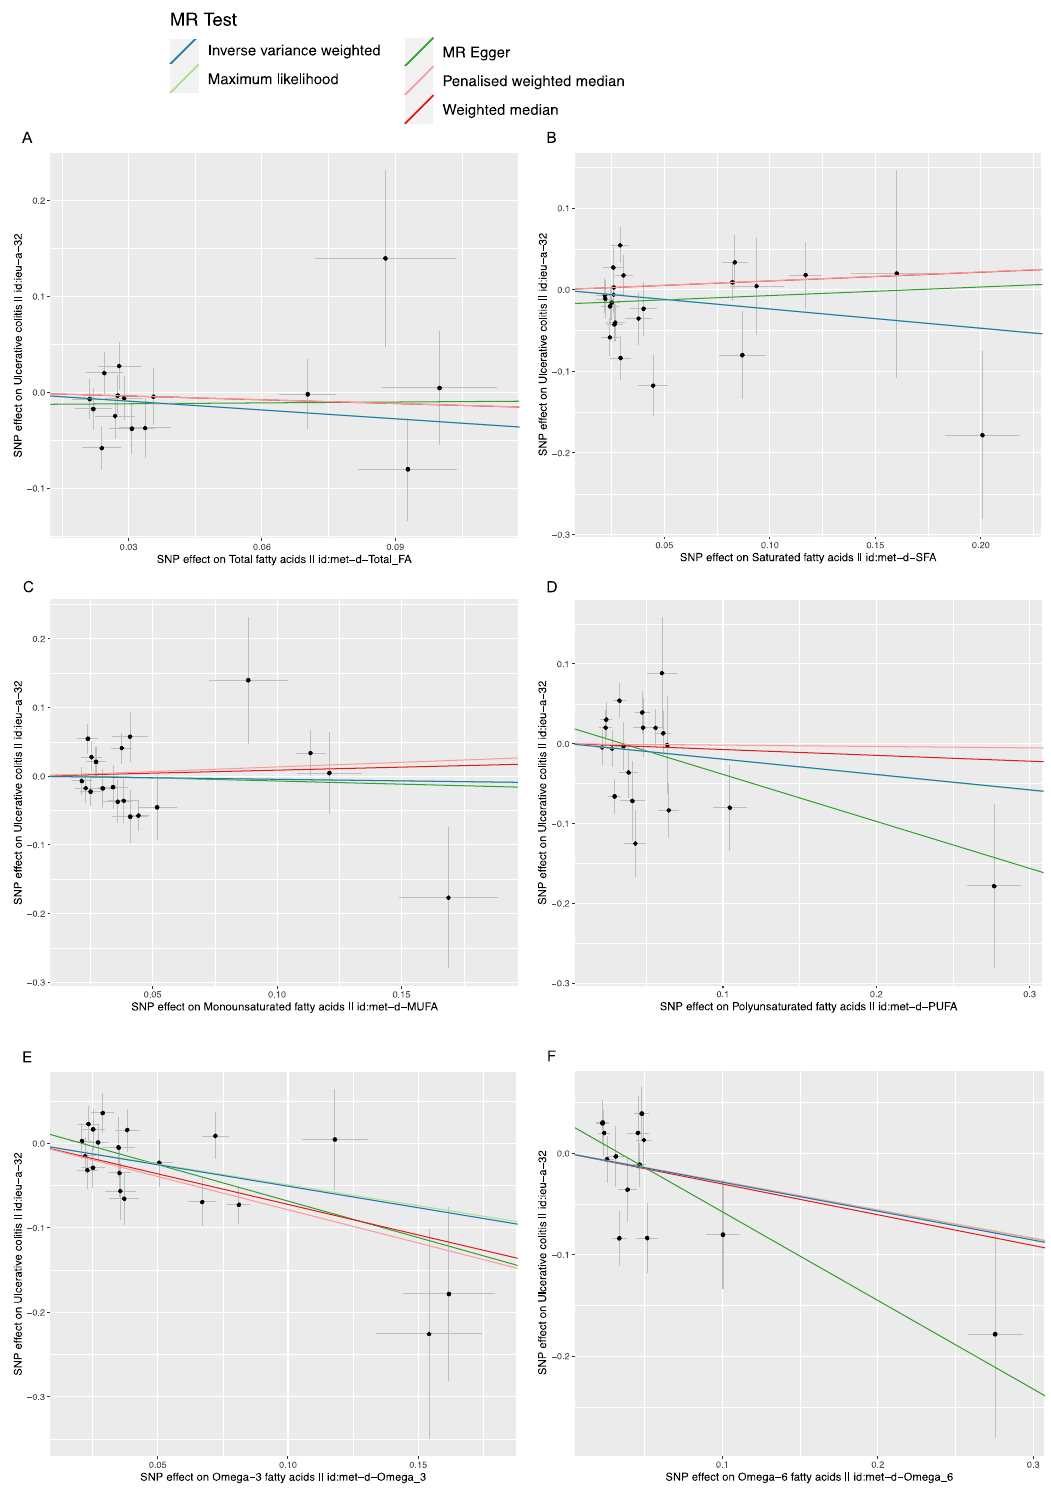
Figure 2. The scatter plot of fatty acids (FAs) and Ulcerative colitis (UC), X -axis, the single nucleotide polymorphism (SNP) effect and standard errors (SEs) on each of the selected SNPs from FA genome-wide summary association study (GWA) dataset Y -axis, the SNP effect and SEs on UC from Crohn’s disease (CD) Genome-wide summary association study (GWA) datasets. ( A ) Analysis of Total FA and UC; ( B ) Analysis of saturated FA and UC; ( C ) Analysis of monounsaturated FA and UC; ( D ) Analysis of polyunsaturated FA and UC; ( E ) Analysis of Omega-3 FA and UC; ( F ) Analysis of Omega-6 FA and